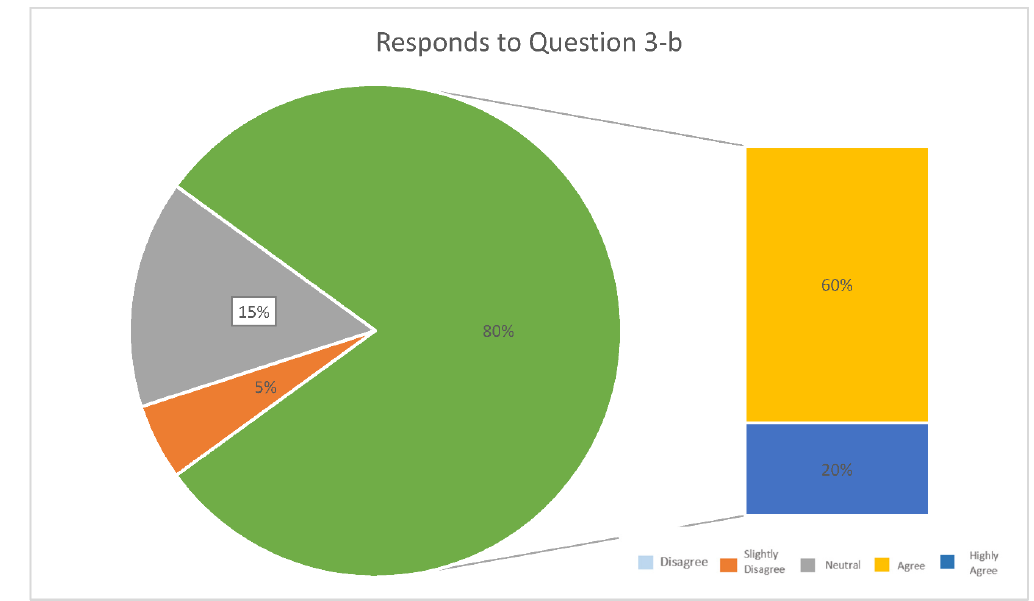
Figure 11. Responses to Question 3-b.